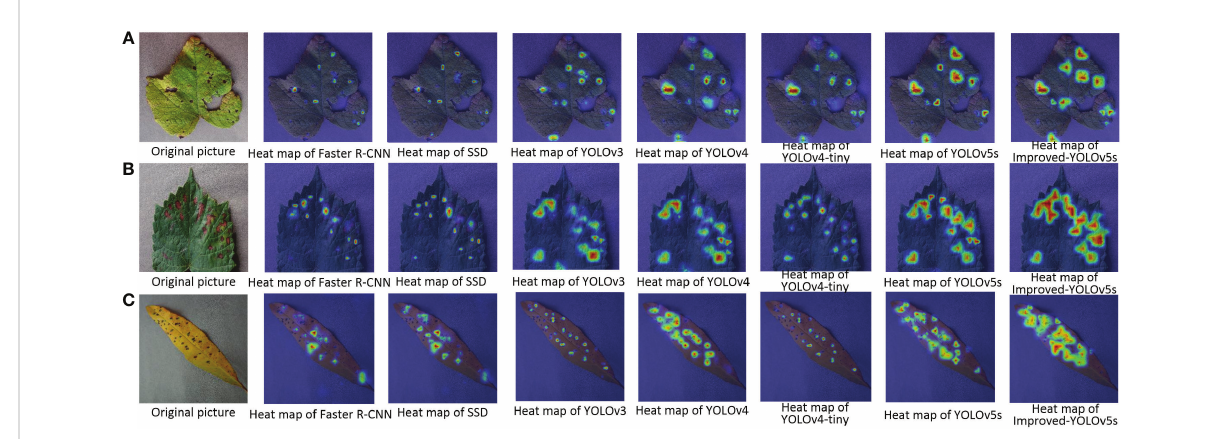
FIGURE 9 Pictures of the heat map detection of diseased leaves under different target detection models. (A) Grape Leaf Blight; (B) Grape Black Measles; (C) Peach Bacterial